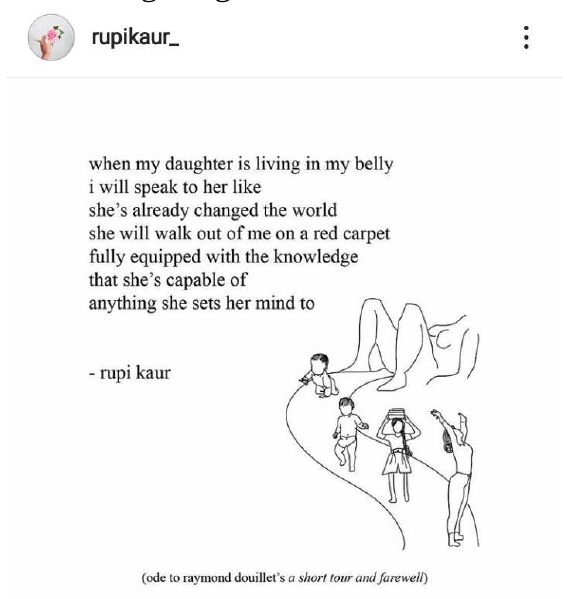
Figure 1. Screenshot of Kaur’s poetry: Short and